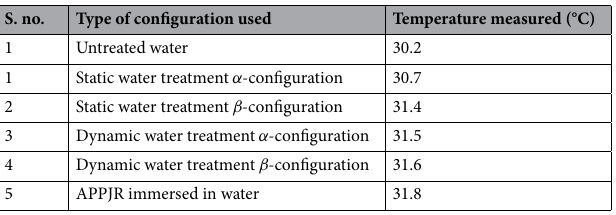
Table 1. Mean value of water temperature measured during experiments.